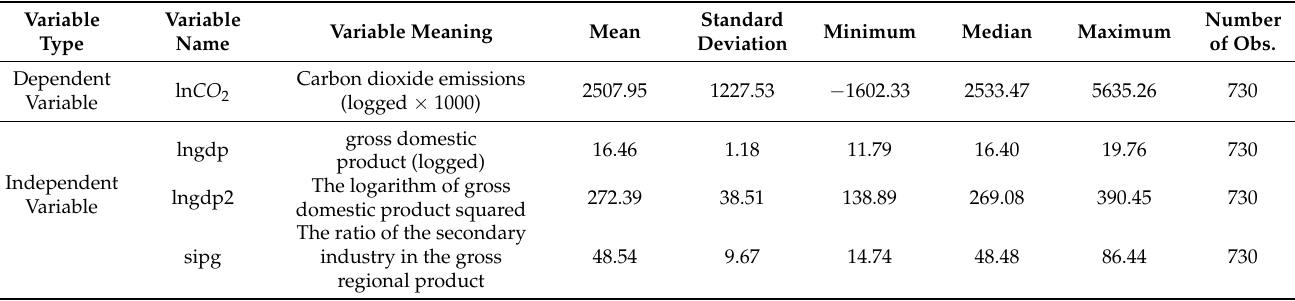
Table 2. Variable description and descriptive